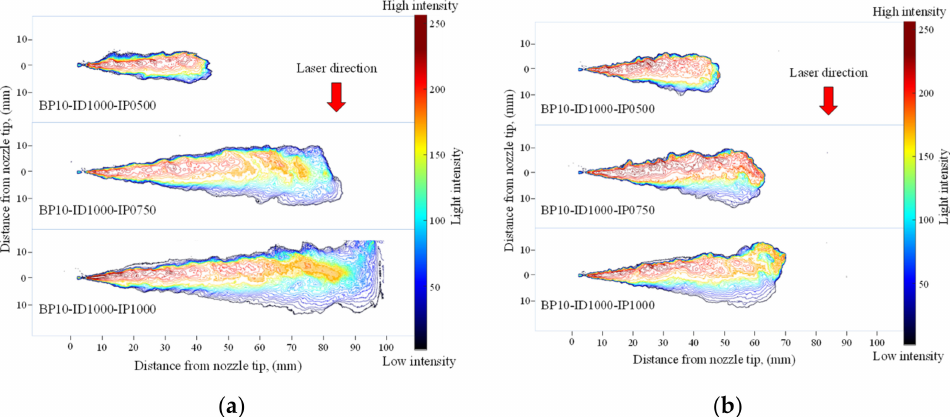
Figure 12. The distribution of GB05 spray density under back pressures of ( a ) 10 bar, and ( b ) 50 bar with an injection duration of 1000 µ s and injection pressures of 500, 750 and 1000